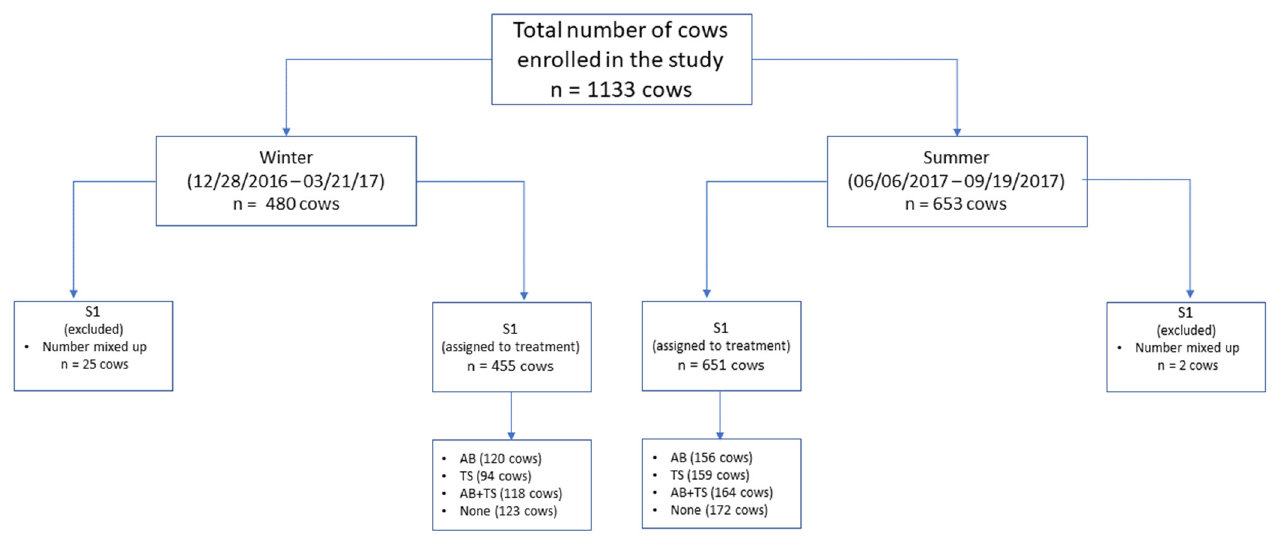
Figure 1. Schematic representation of the enrolled cows in the randomized field trial for dry cow therapy. AB (cows received only intramammary antibiotic tubes at dry-off), TS (cows received only internal teat sealants at dry-off), AB + TS (cows received both intramammary antibiotic tubes and internal teat sealants at dry-off) and None (cows did not receive any treatments at dry-off). A total of 1133 cows were enrolled in the study; 27 were excluded due to errors transcribing their identification, resulting in a total of 1106 cows included for final analysis.